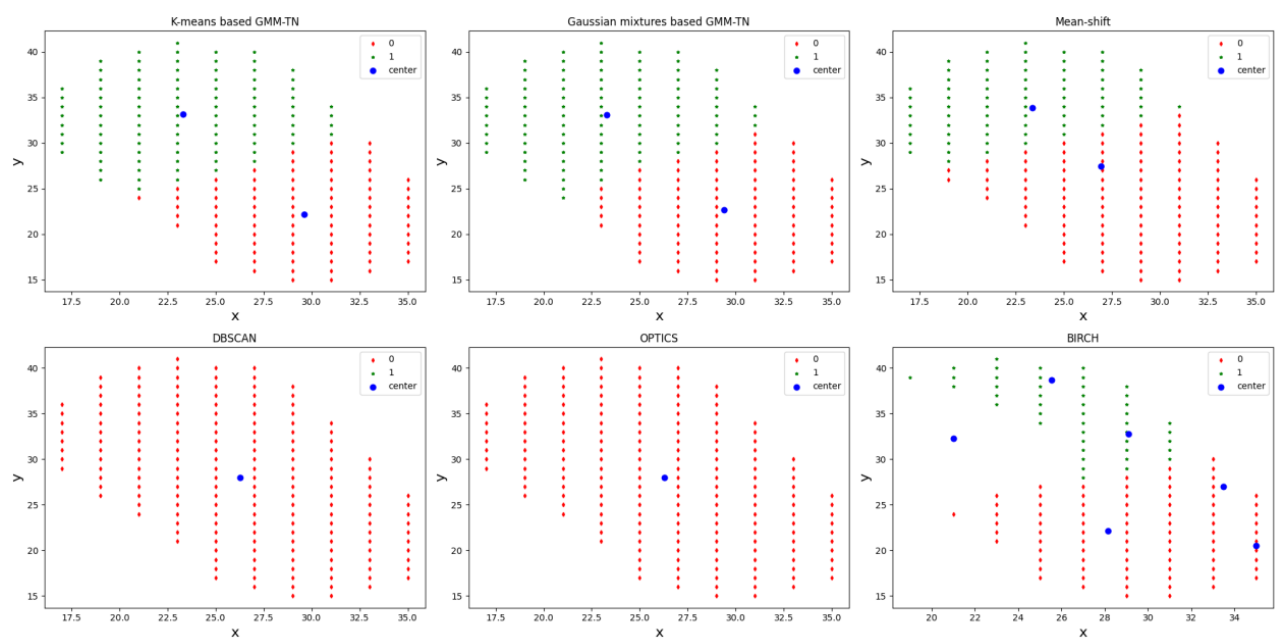
Figure 17. Automatic target number estimation results (double overlapped targets) using K-means- based GMM-TN, Gaussian-mixtures-based GMM-TN, Mean-shift, DBSCAN, OPTICS, and BIRCH.